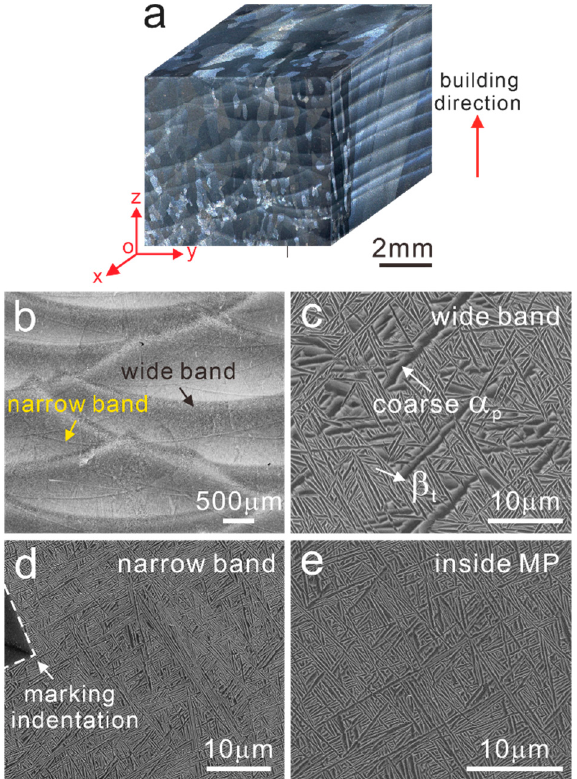
Figure 2. ( a ) Stereoscope optical image, ( b ) OM image and ( c – e ) SEM images of the MP in the as- deposited TC11 sample.